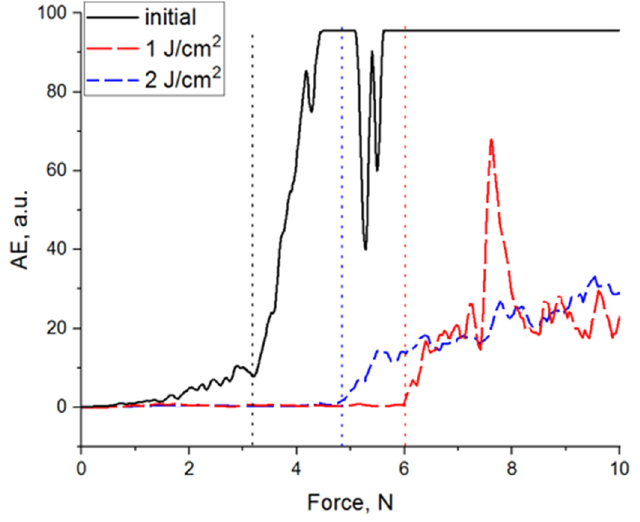
Figure 7. The scratch-test results of the AlN coating on the 321 steel substrates.